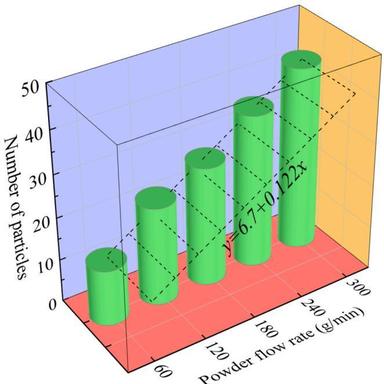
Graph of the effect of powder flow rates on the number of cBN particles bound.